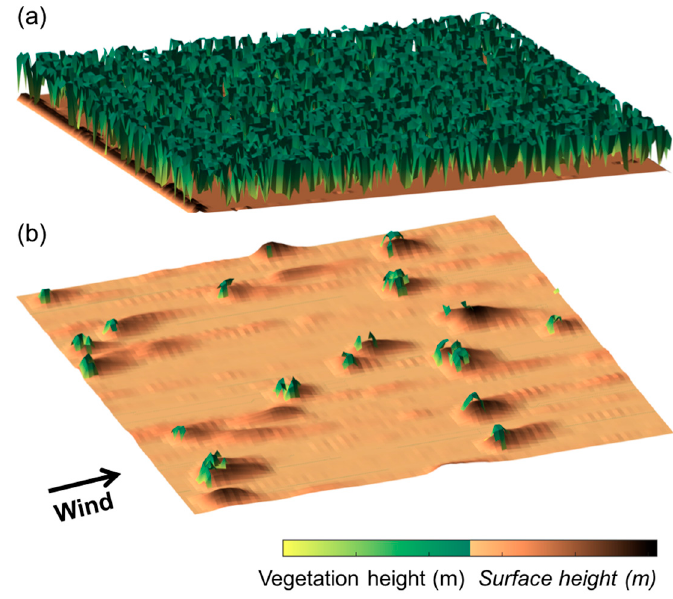
Figure 9. Three-dimensional representations of combined vegetation and surface morphology for a coupled Vegetation and Sediment TrAnsport model (ViSTA) simulation, with conditions similar to those observed in the Skeleton Coast National Park, Namibia. Figures show landscape at: ( a ) beginning of simulation, where the domain is artificially populated with shrubs; ( b ) after 25 years of arid conditions, where an equilibrium landscape of nebkha dunes emerges. Black arrow shows average wind direction (adapted from [26] (p. 22)).